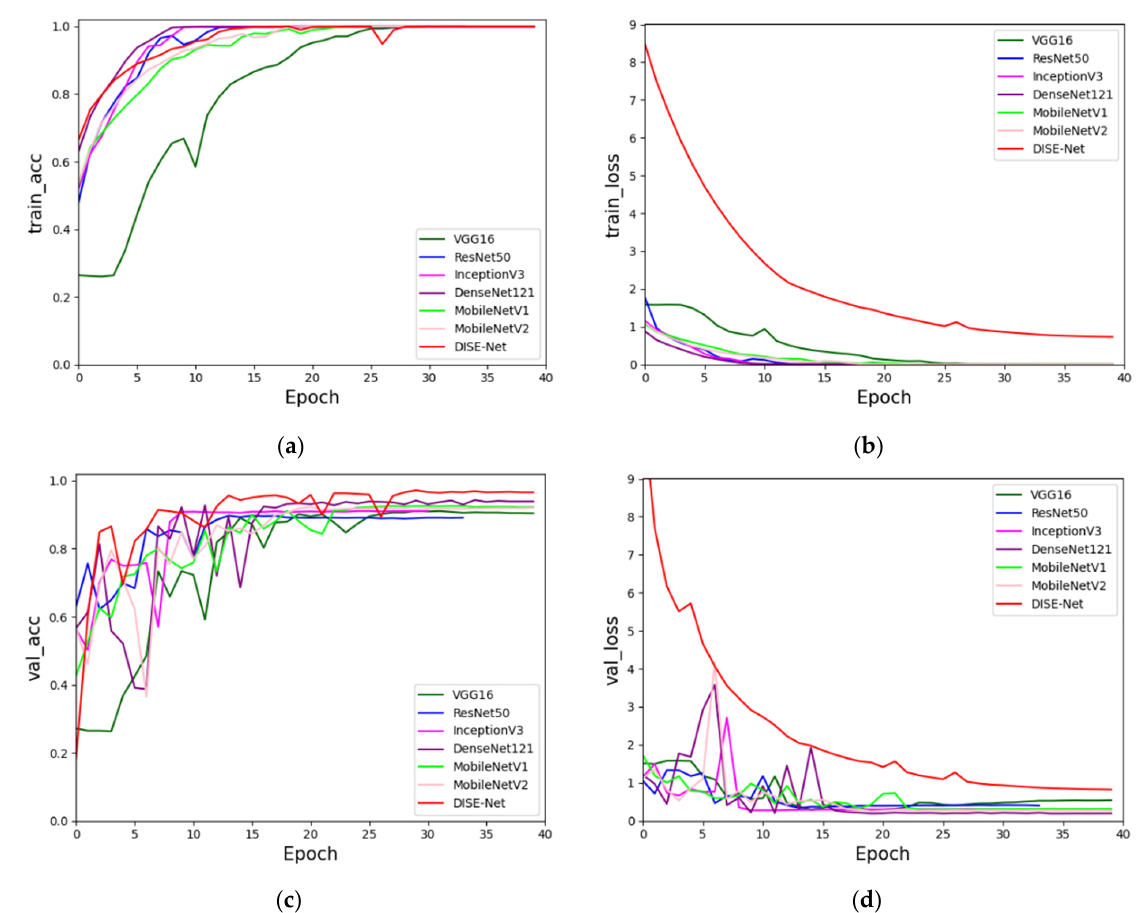
Figure 11. Accuracy curve and loss curve ( a ) Training accuracy curve; ( b ) Training loss curve; ( c ) Validation accuracy curve; ( d ) Validation loss curve;